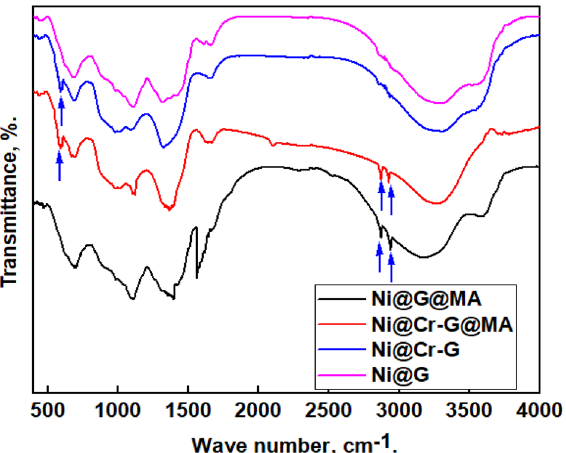
Figure 2. FTIR spectra of the coated steel with Ni@G, Ni@Cr-G, Ni@G@MA, and